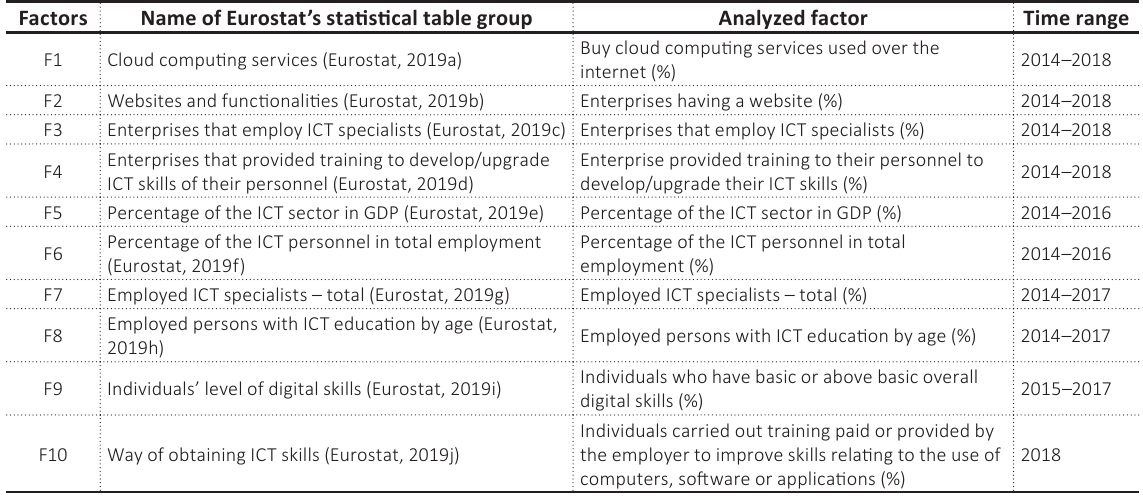
Table 2. List of tables with statistical